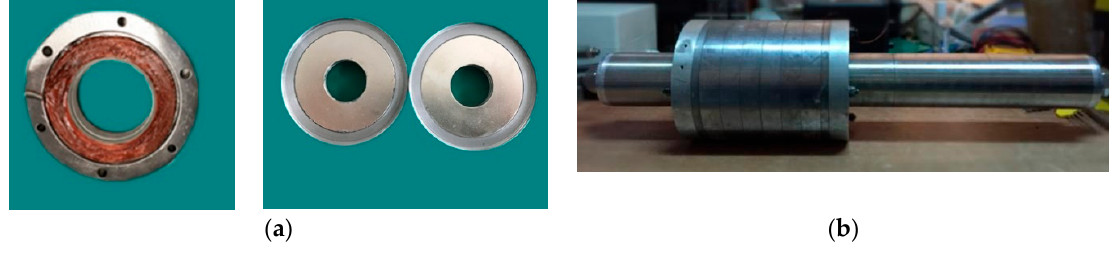
Figure 13. The prototype of MI-TLPMG: ( a ) a part of the stator and translator; ( b ) the full view of the manufactured MI-TLPMG.